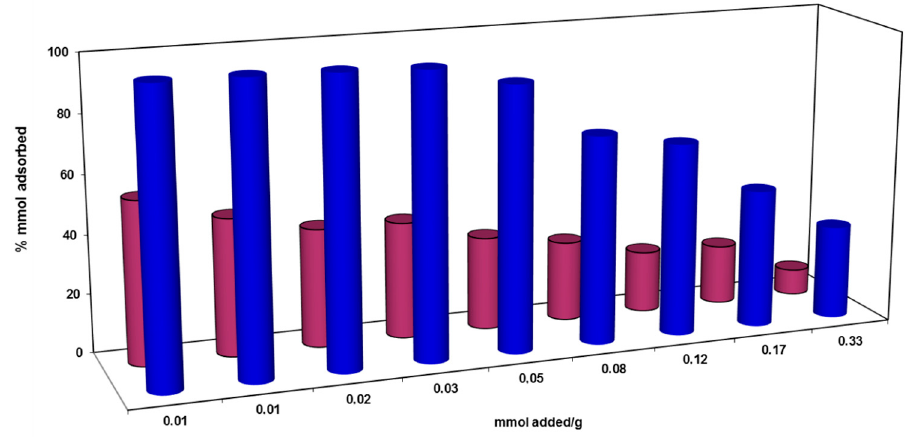
Figure 5. Remediation of an azo dye from industrial textile wastewater by Φ 5 -PPH recorded at 270 nm ( ) and compared with raw PPH ( ).